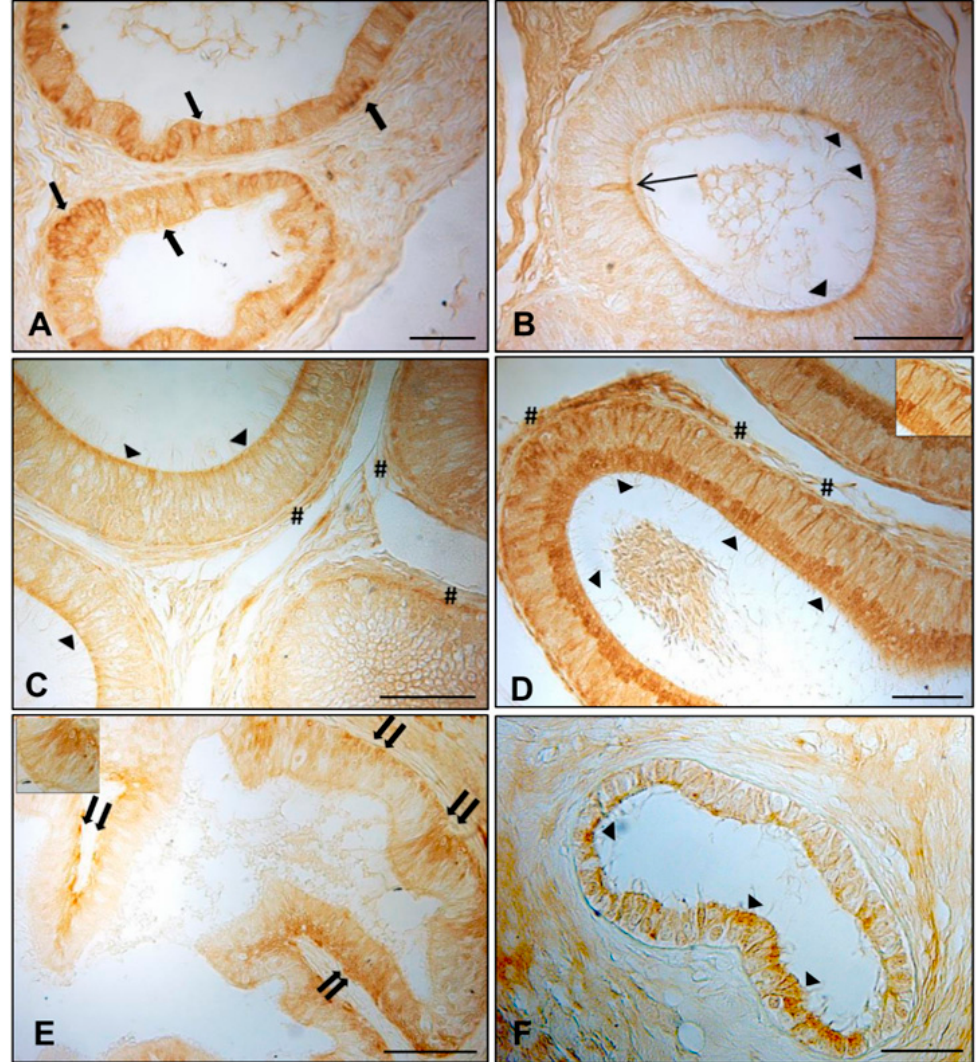
Figure 2. Immunohistochemical staining of AQP8 in normal and cryptic efferent ductules and epididymal segments. In the normal dogs, AQP8 IR was described in ( A ) cytoplasm of the efferent ductules epithelium (arrows), ( B – D ) the apical cytoplasm (arrowheads) of the principal cells of all the epididymal segments, ( C , D ) the basal portion of the principal cells of the corpus and cauda (pounds), and ( B ) in some narrow cells of the caput (line arrow). In the cryptorchid epididymis, basal cells (double arrows) were observed in the caput ( E ), while only the apical portion of the principal cells of the cauda (arrowheads) exhibited immunoreactivity ( F ). Bar: 25 micron.